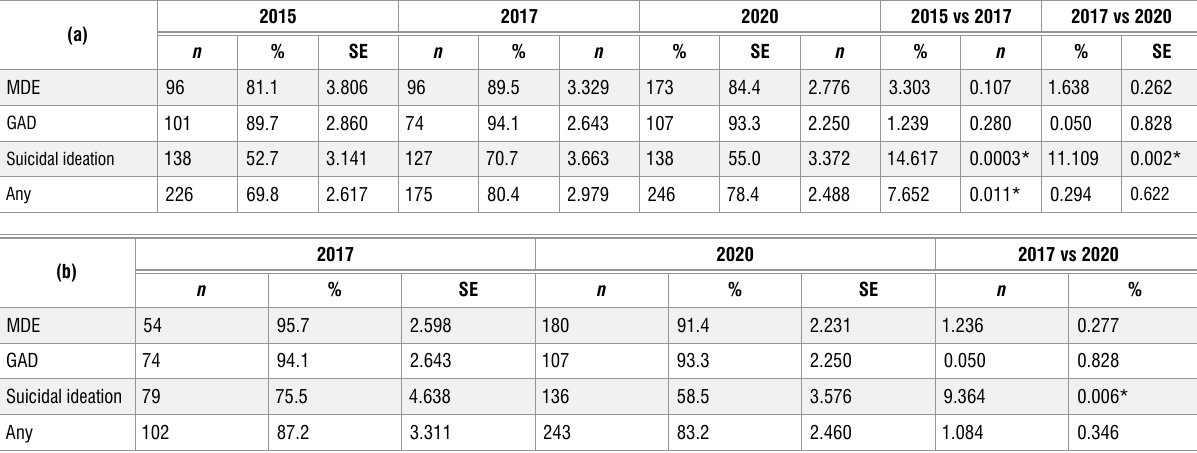
12-Month prevalence among lifetime cases as of 2 years ago for major depressive episode (MDE), generalised anxiety disorder (GAD)